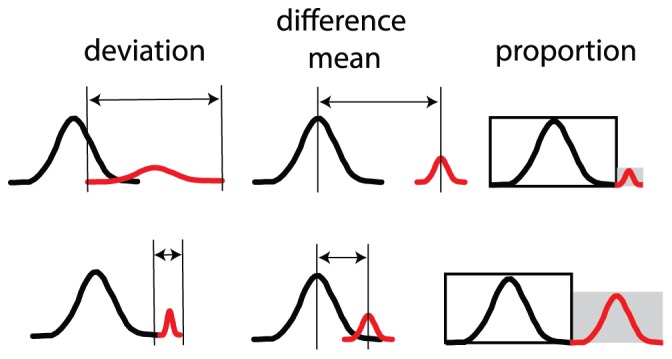
Scheme illustrating the three parameters, mean difference between large and small subpopulation, standard deviation of small subpopulation and proportion of small subpopulation, that were changed in a computer simulation to create variations of mixed populations upon which the PS methods of subpopulation determination were tested (see Figure 7, 9).Black, large subpopulation. Colour, small subpopulation.